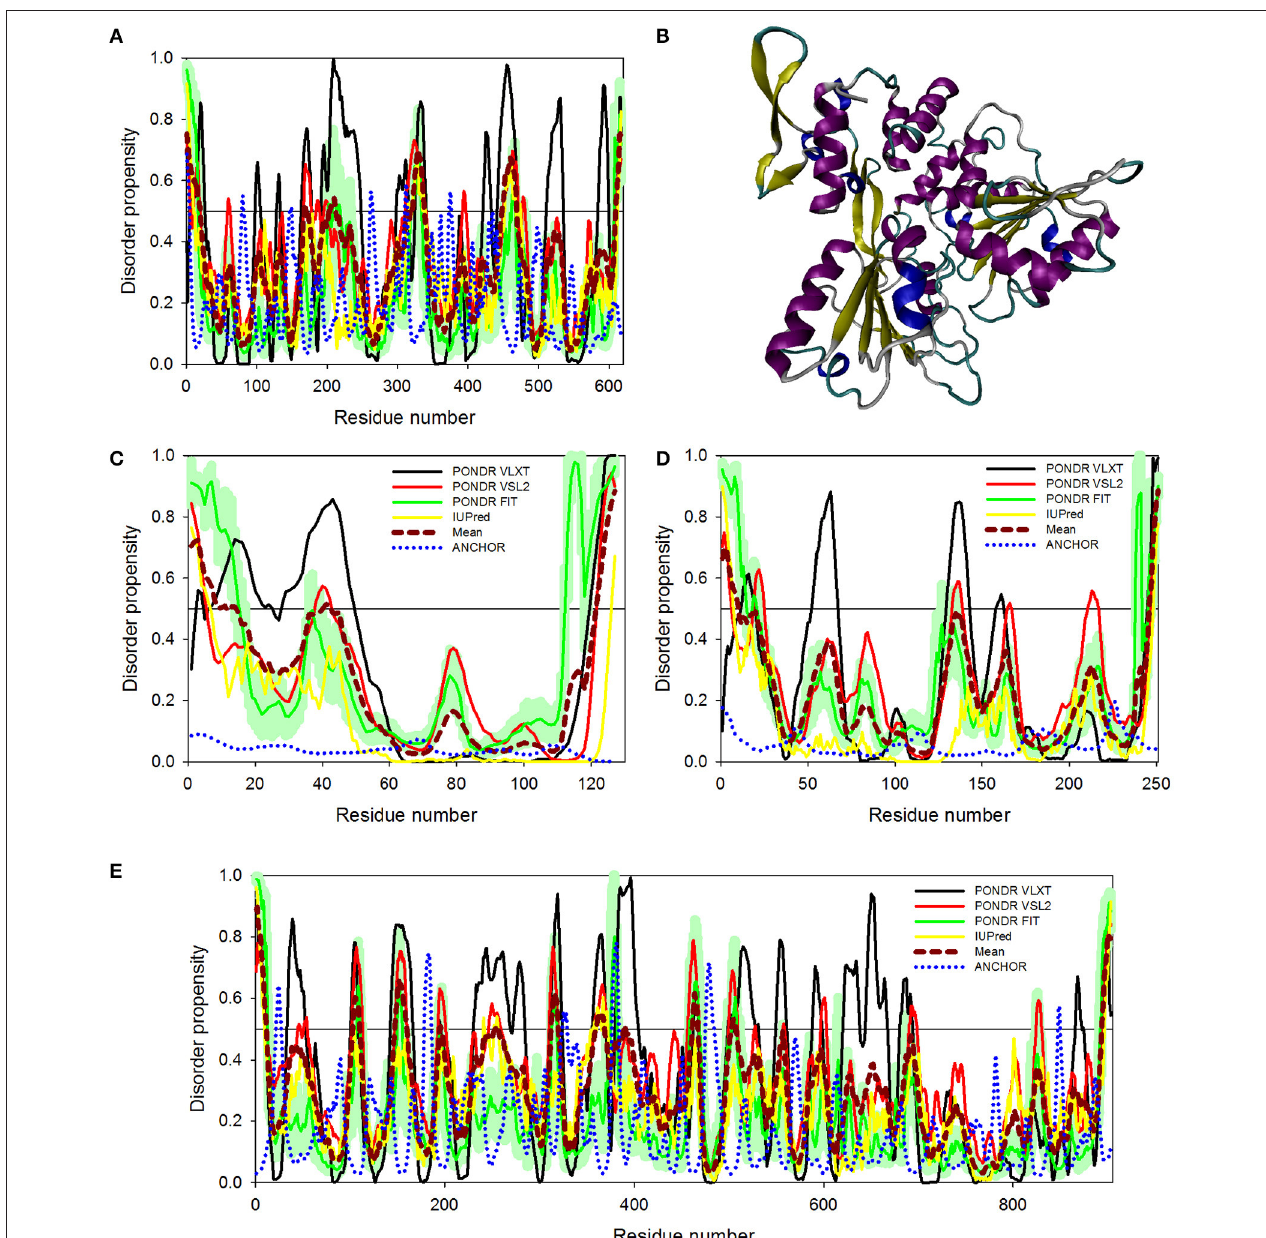
FIGURE 6 | Disorder predispositions of non-structural proteins NS3 (A), NS4A (C) , NS4B (D) , and NS5 (E) . Disorder profiles generated by PONDR ® VLXT, PONDR ® VSL2, PONDR ® FIT, and IUPred are shown by black, red, green, and yellow lines, respectively. Dark red dashed line shows the mean disorder propensity calculated by averaging disorder profiles of individual predictors. Light green shadow around the PONDR ® FIT shows error distribution. Blue dotted lines correspond to the result of the functional disorder analysis using ANCHOR algorithm. (B) 3D-structure of the helicase domain of the ZIKV NS3 protein (PDB ID: 5JMT) (Tian et al., 2016). Structure is colored according to the secondary structure content. Structural representation have been rendered using VMD (Humphrey et al.,